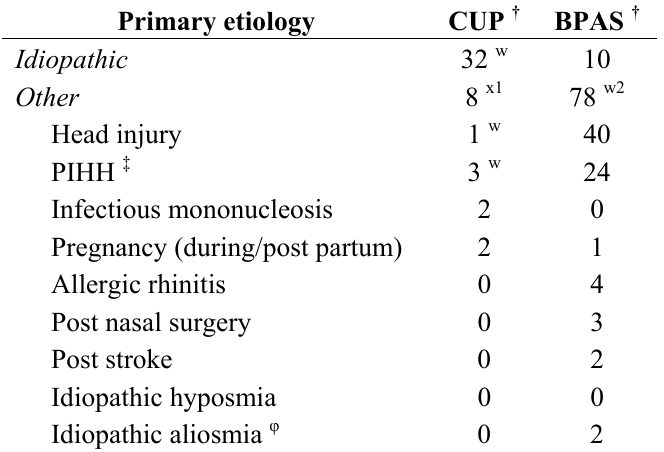
Table 4. Phantosmia etiology in patients with